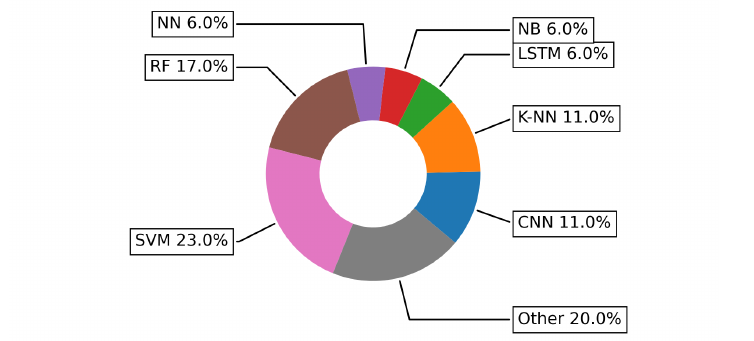
Figure 20. Specific ML and DL algorithms more frequently used in addressing the Monitoring challenge.